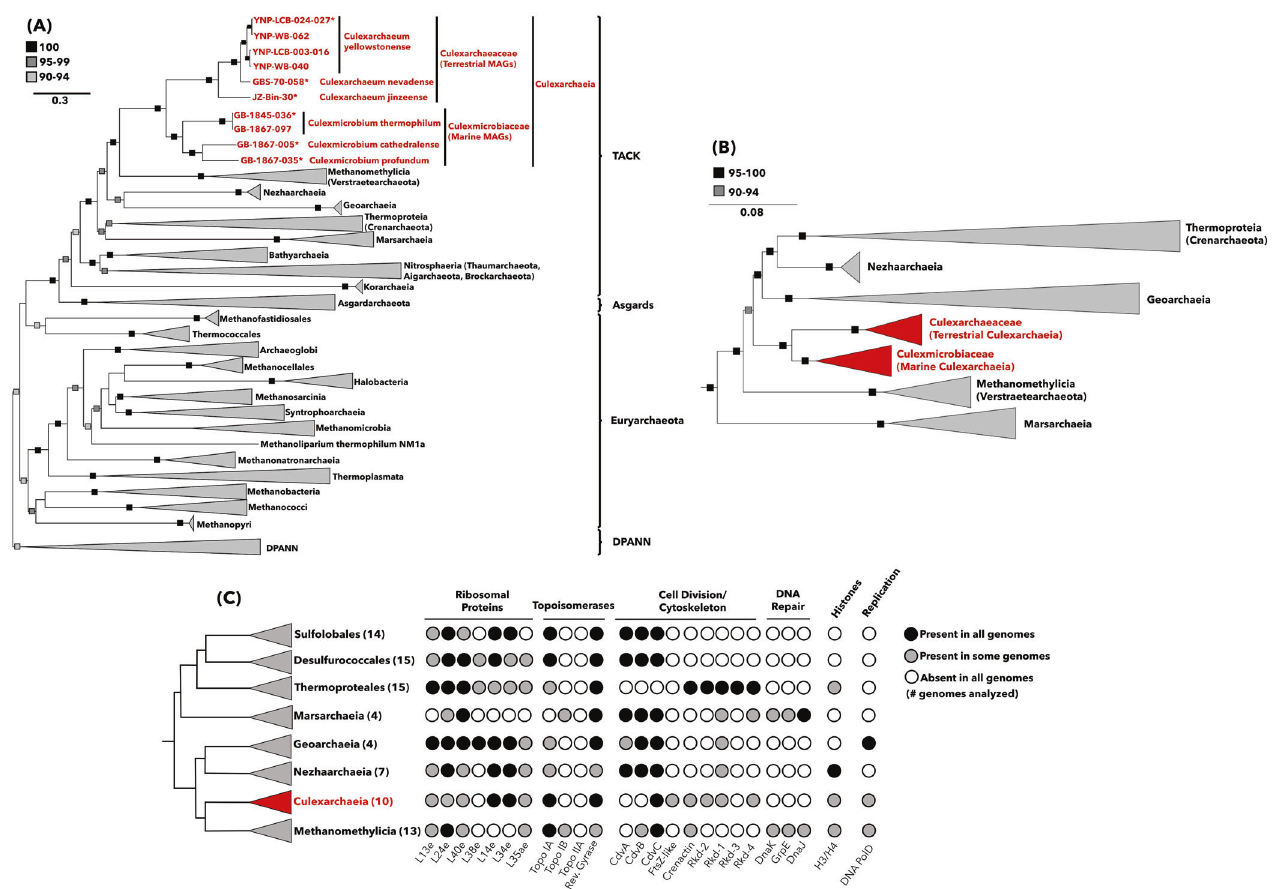
Fig. 1 Phylogenetic analysis of Culexarchaeia MAGs and comparison of gene patterns involved in central information-processing machinery. A Maximum-likelihood tree, inferred with IQtree and the best- fi t LG + C60 + F + G model, using a concatenated set of 43 conserved arCOGs (Supplementary File 1). Ultrafast bootstrap support values of 100, 95 – 99, and 90 – 94 are indicated. *, indicates genome ID used to designate type species. B Maximum-likelihood tree, inferred with IQtree and best- fi t GTR + F + G model, using 16S rRNA gene sequences longer than 1000 bp. Ultrafast bootstrap support values of 95 – 100 and 90 – 94 are indicated. C Comparison of presence-absence patterns for genes involved in central information-processing machinery among TACK lineages related to Ca . Culexarchaeia. Genes found in all genomes analyzed, some genomes analyzed, and absent from all genomes analyzed are indicated with black, gray, and white circles, respectively. The number of genomes screened in each clade are indicated in parentheses, and a full list of the presence-absence pattern for individual genomes can be found in Supplementary File